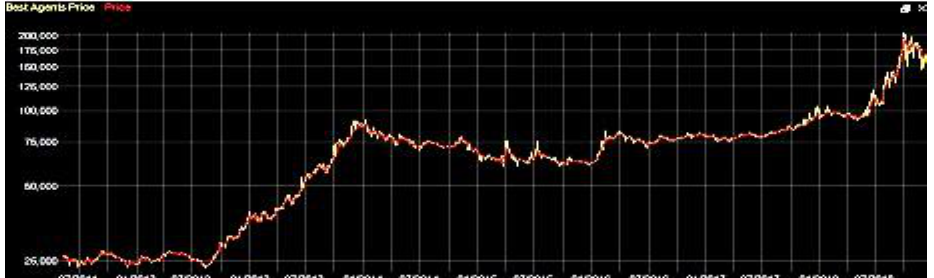
Fig.5. Time series plot of “TEPIX” at 20% best gents group size; the red curve is the historical “TEPIX” quotes; the yellow curve is the series estimated by best